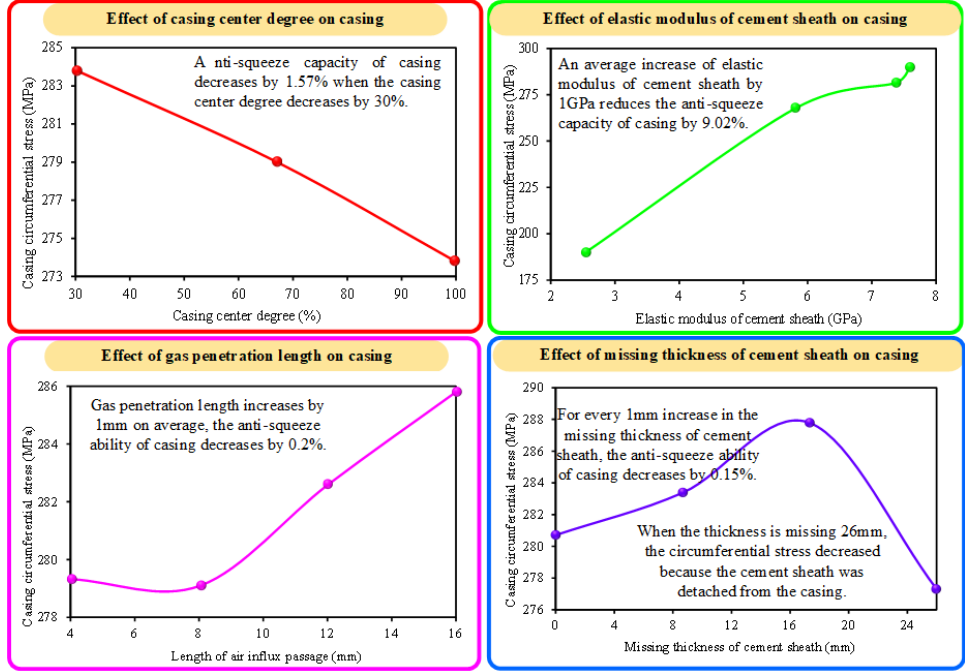
Figure 7. Relationship between casing circumferential stress and quality, performance of cement sheath.